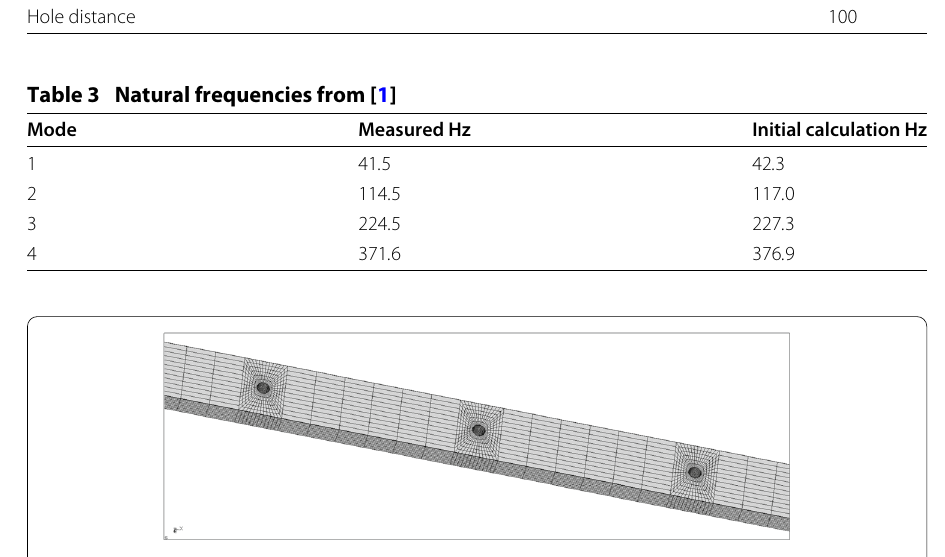
Fig. 7 Meshing at holes. Mesh at holes after mesh independence study